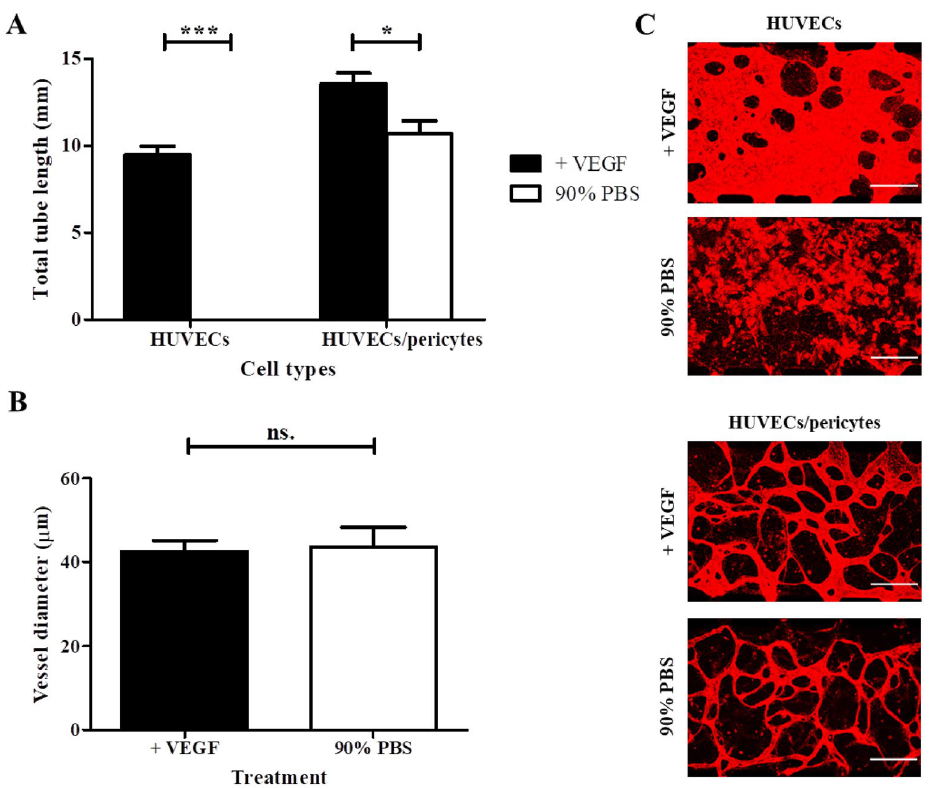
Figure 5. The impact of pericytes on network stability in response to starvation. ( A ) 72 h nutrient starvation resulted in the entire collapse of HUVEC networks in monocultures. In contrast, HUVEC/ pericyte networks persisted, although they apparently regressed compared with untreated conditions (mean ± SEM total tube length, 10.7 ± 0.7 vs 13.5 ± 0.6 mm/field of view, respectively). ( B ) Impact of starvation on tube diameter in co-cultures, showing no significant difference after starvation. ( C ) Representative images, z-projection images were generated using confocal images. Red, CD31. Scale bar: 300 µm. N = 3; n.s., non significant; *, p < 0.05; ***, p <